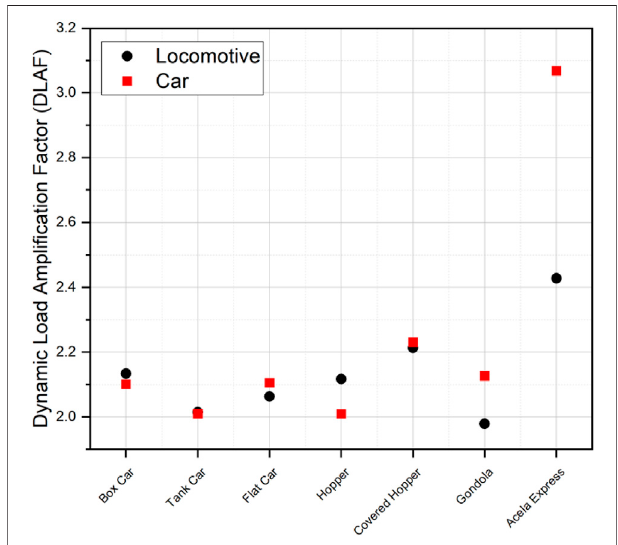
FIGURE 11 | Maximum rail-tie reaction forces ampli fi